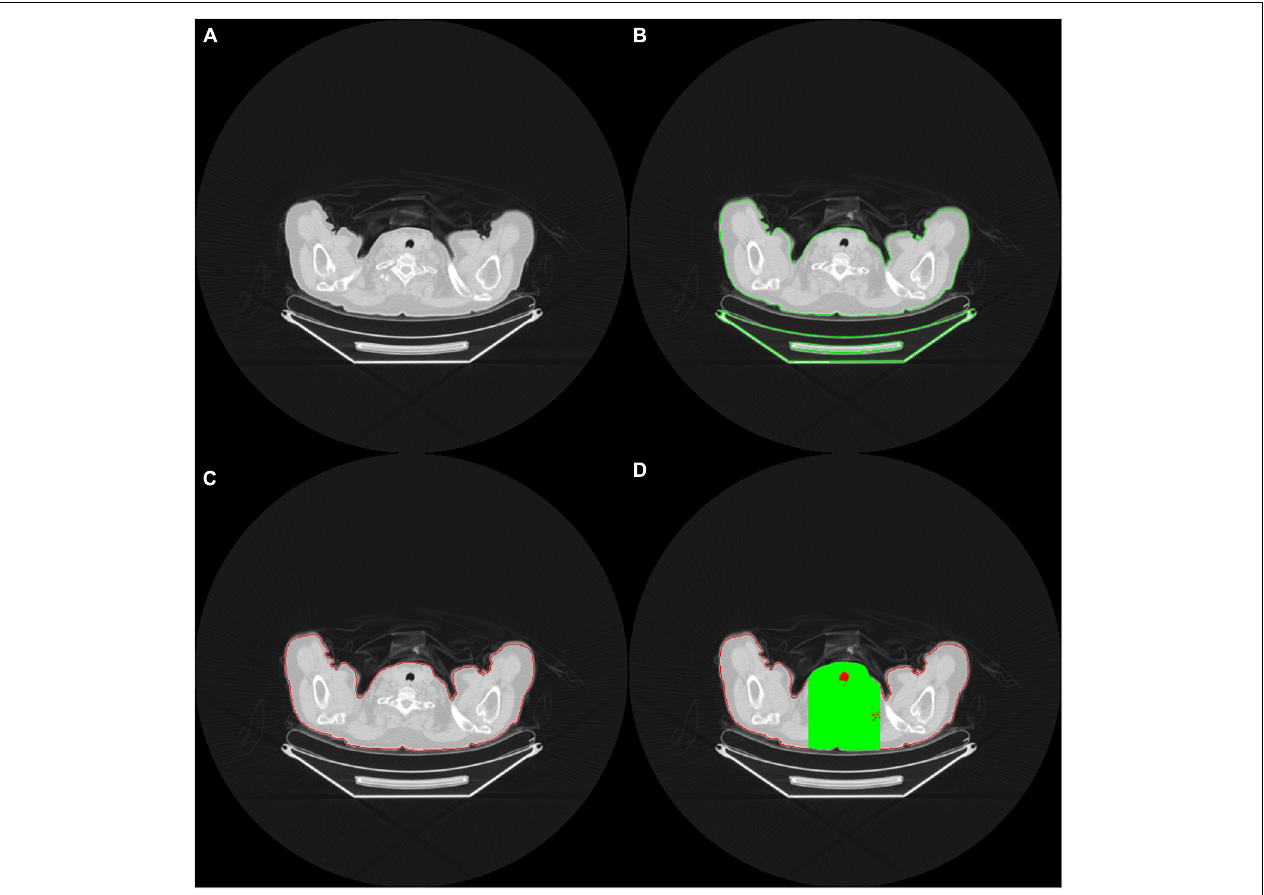
FIGURE 2 | (A) The red contour delineates the air (black area) within the tracheal lumen, which helps the program determine the upper edge of the lungs (B) OpenCV identifies the contour area of the body on the CT images (C) Body contour block (red contour block) (D) Green area indicates the limited calculation area. Only the black area in the green range is included in the calculation of the